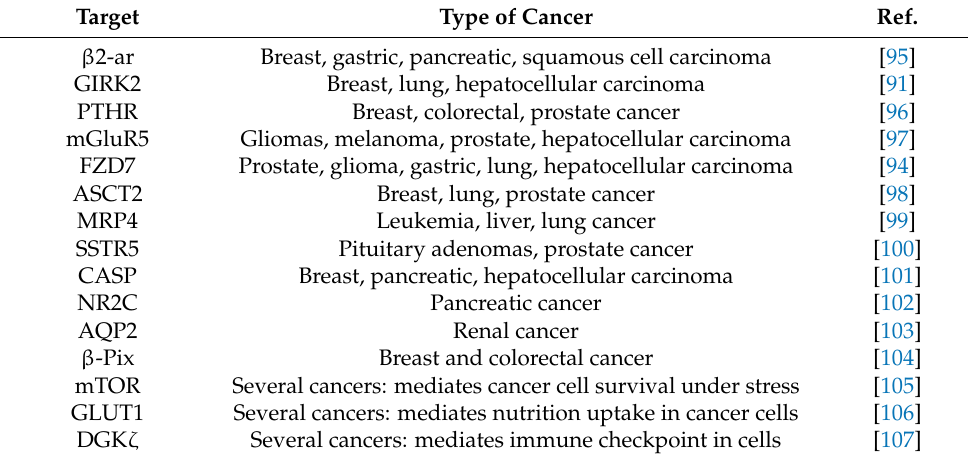
Table 3. SNX27 associated proteins reported in